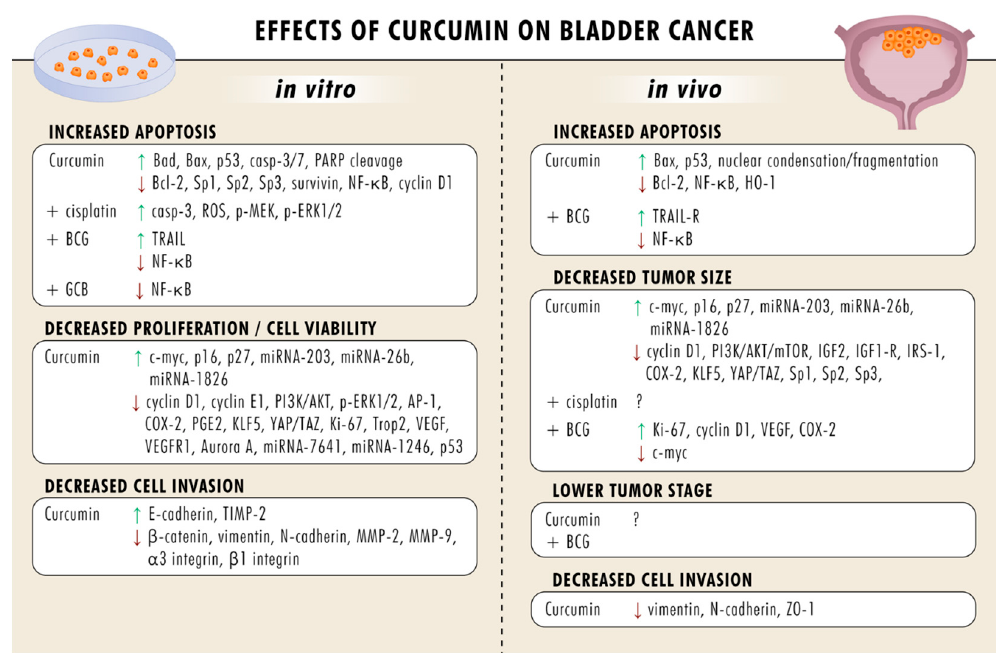
ff ects in vitro and in vivo. Abbreviations: Akt: proteinkinase Figure 1. Overview of curcumin’s effects in vitro and in vivo. Abbreviations: Akt: proteinkinase B; Figure 1. Overview of curcumin’s e